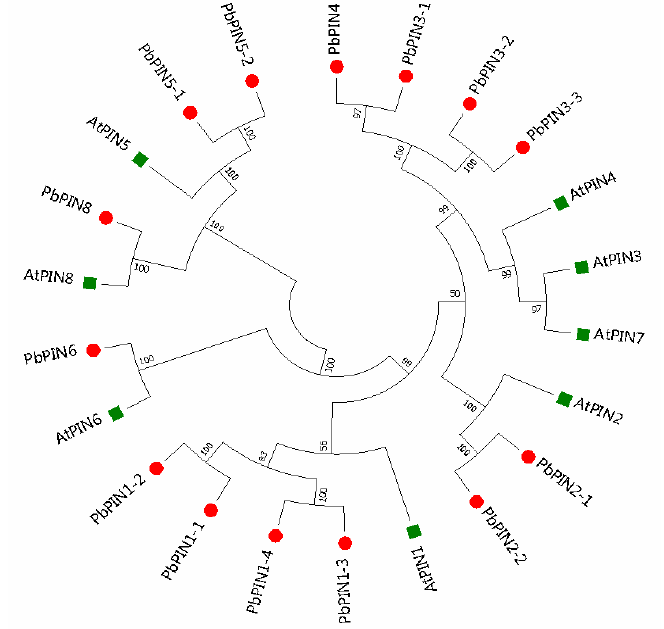
Figure 1. Phylogenetic relationships of PINs between Pyrus bretschneideri and Arabidopsis . Complete alignments of 22 PINs from P. bretschneideri and Arabidopsis were performed to construct a phylogenetic tree using MEGA 7.0 software with the neighbor-joining method. Bootstrap values are indicated on the nodes of branches. The green dots and red squares represent AtPINs and PbPINs, respectively. The 14 PbPINs were denominated according to the sequence alignments and the phylogenetic tree.